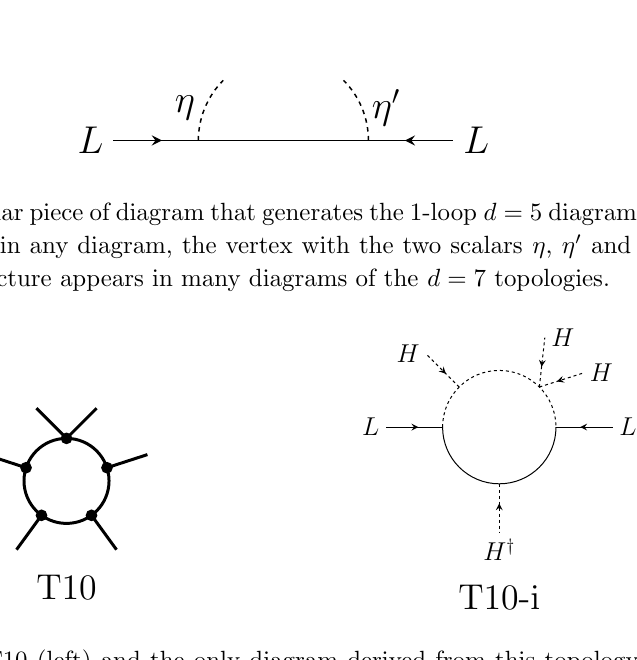
Figure 7 . Topology T10 (left) and the only diagram derived from this topology, that can give a genuine model